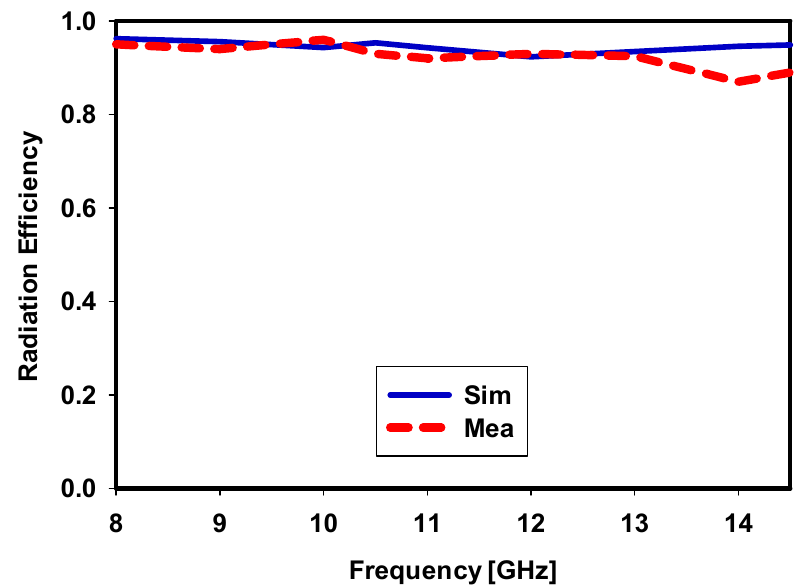
Figure 13. Simulated and measured radiation efficiencies of the design.